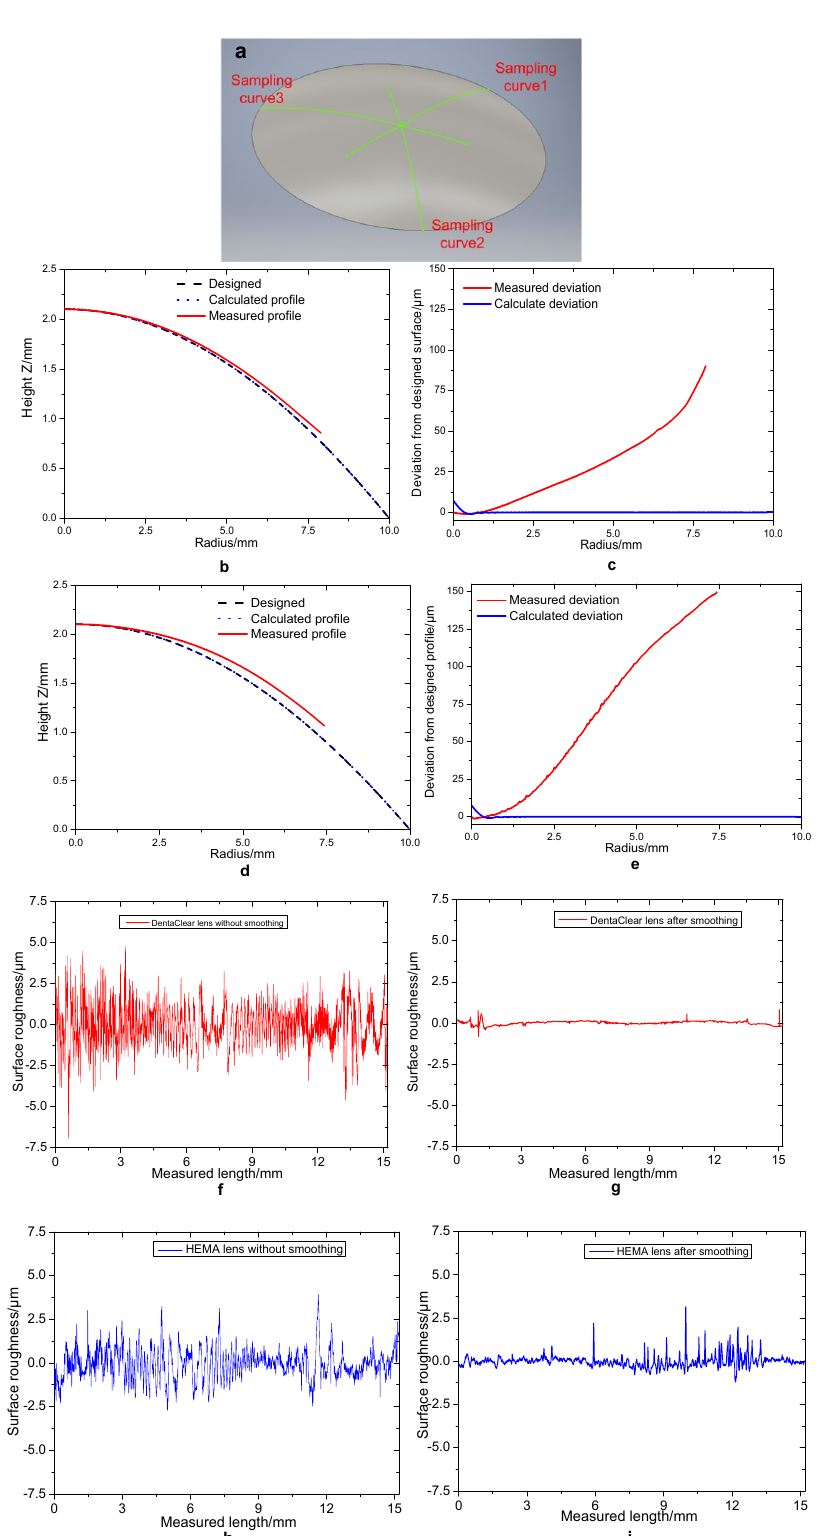
Figure 8. ( a ) Schematic diagram of sampling curves on lens surfaces in the profilometer measurements: each curve has a length of 15.2 mm. ( b ) Printed surface profile and ( c ) deviation of DentaClear lenses compared to the designed profile. ( d ) Printed surface profile and ( e ) deviation of HEMA lenses compared to the designed profile. ( f ) Surface roughness of printed DentaClear lens without smoothing. ( g ) Surface roughness of printed DentaClear lens after smoothing. ( h ) Surface roughness of printed HEMA lens without smoothing. ( i ) Surface roughness of printed HEMA lens after smoothing. Table 1. Surface properties of the lenses without and after smoothing.